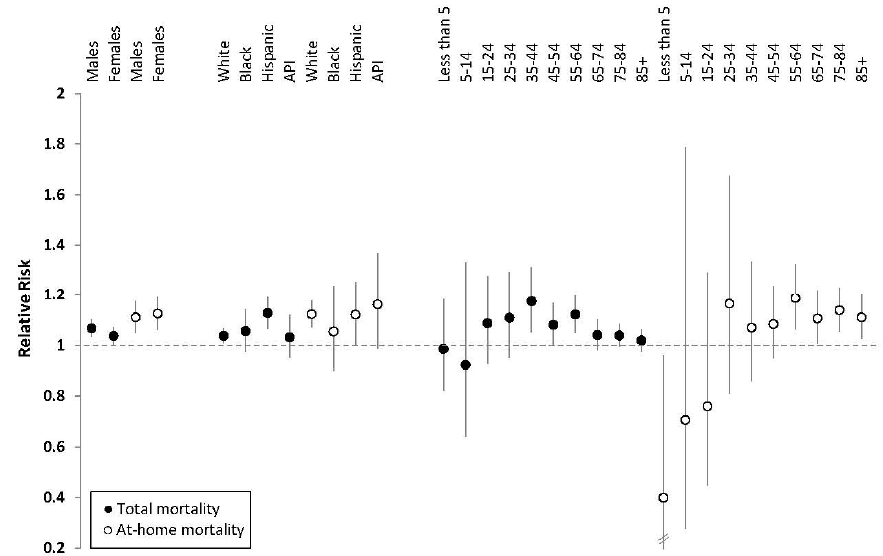
Figure 1. Heat wave relative risks (RRs) for total deaths (solid circles) and deaths that occurred at-home (hollow circles) by demographic group and 95% confidence intervals (CIs). Notes: Vertical lines represent 95% CIs; the CI for at-home deaths among those less than 5 years of age is wider than the RR scale; API is Asian/Hawaiian/Pacific Islander.